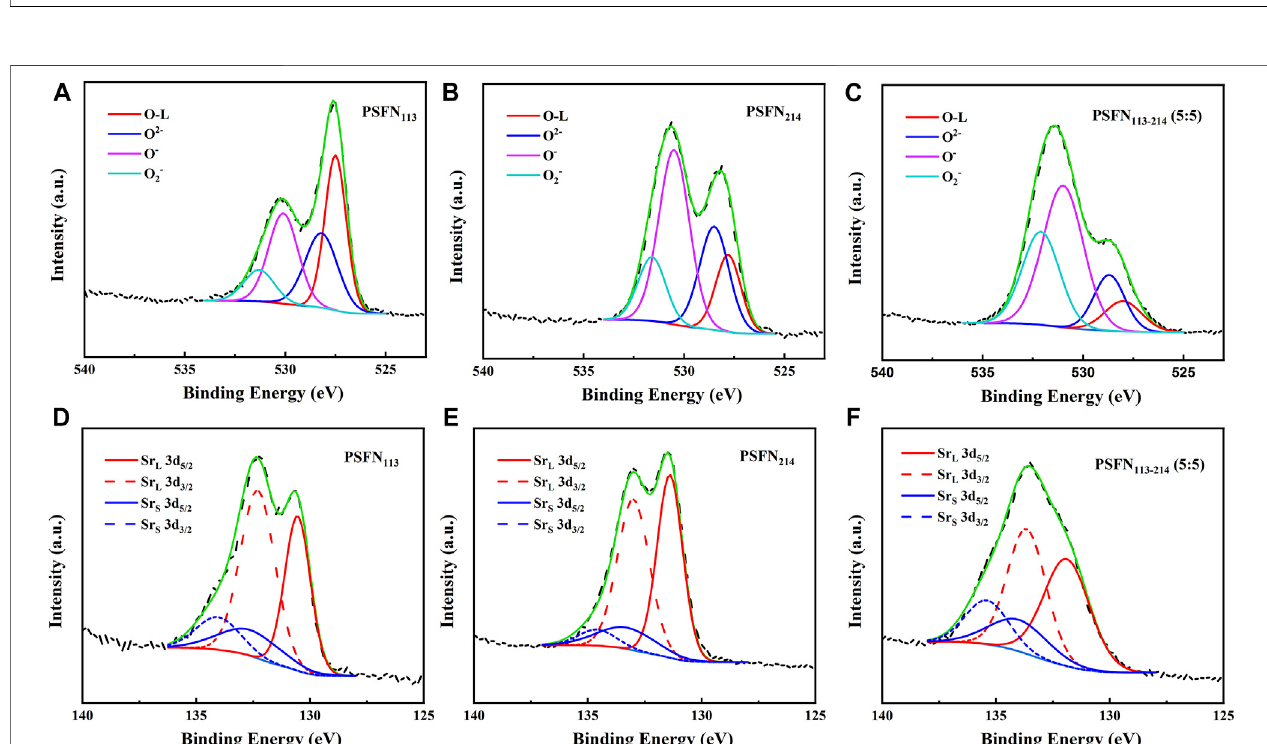
FIGURE 4 | XPS spectra of PSFN 113 , PSFN 214 and PSFN 113-214 (5:5) cathode materials obtained for (A – C) O1s and (D – F) Sr 3d.